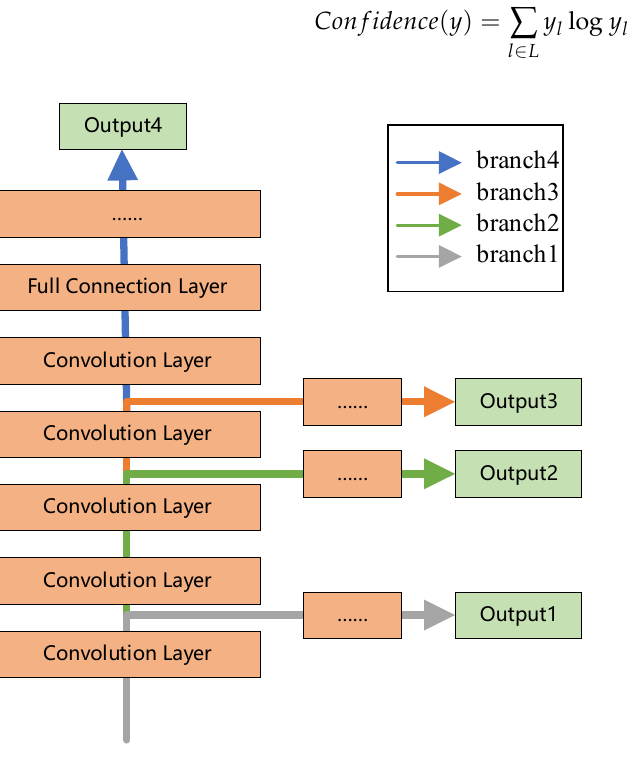
Figure 4. CNN with Figure 4. CNN with branches.